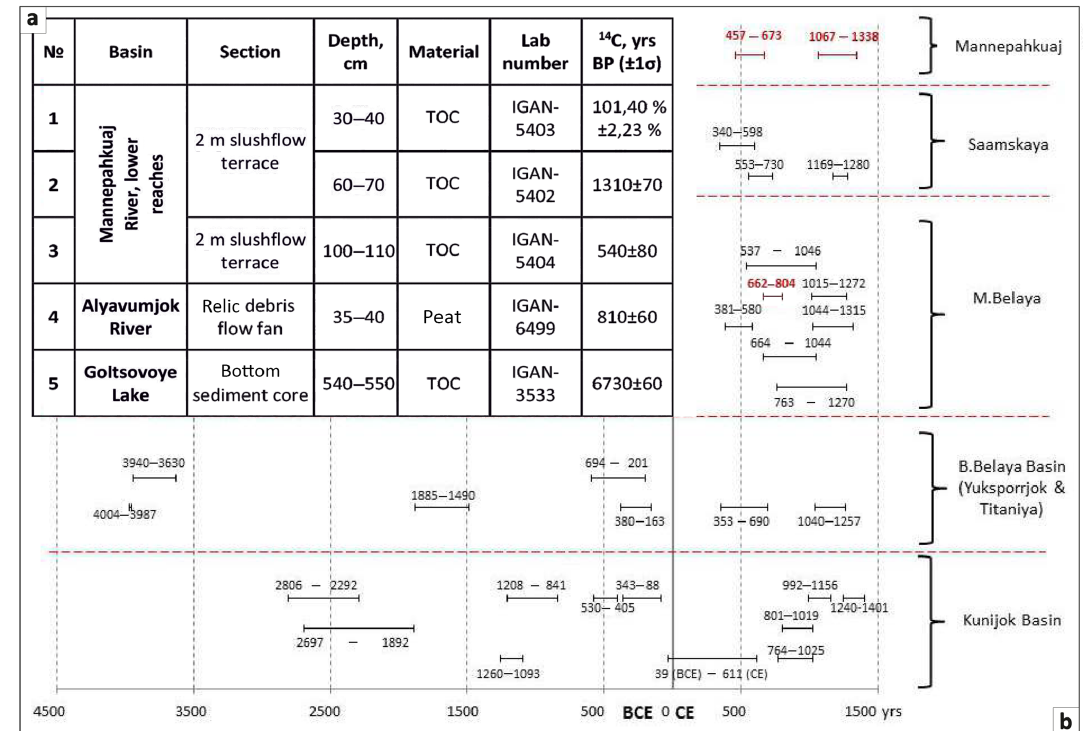
Figure 5. Holocene geochronology for the valleys in the Khibiny Mountains. New 14 C dating results (a) . Intervals (calibrated ages) of buried soil horizons in debris flow fans and slope cones (b)